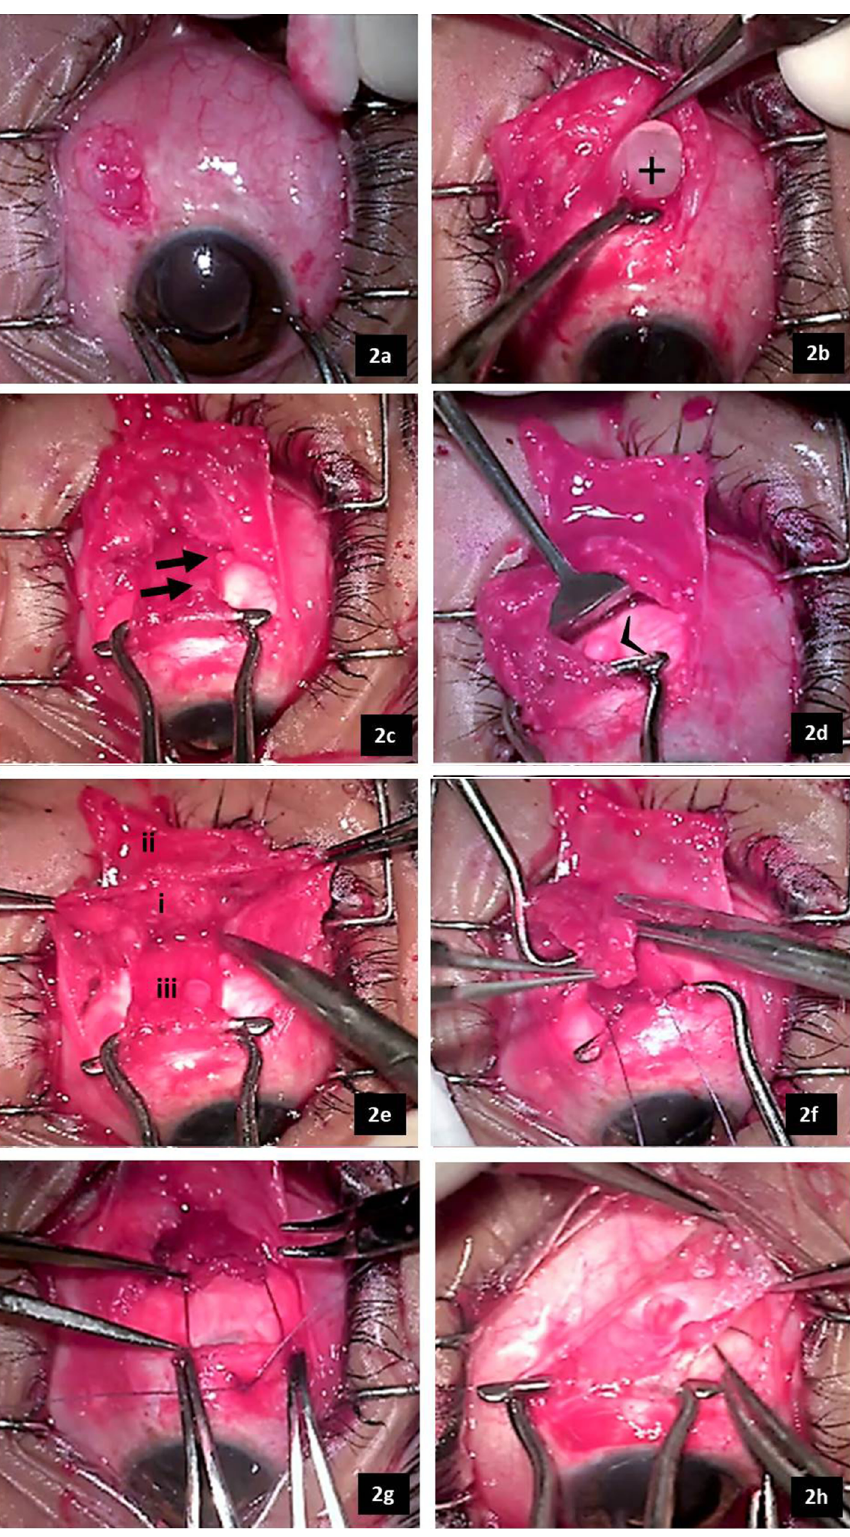
Figure 2: Intraoperative photographs showing the various steps of the strabismus surgery. 2a–g: Intraoperative photographs of the surgical field of lateral rectus recession. 2a: Multiloculated cyst encountered just beneath the conjunctival incision. 2b: Large uniloculated cyst (+) located within the anterior tenon’s capsule at the superior edge of the lateral rectus muscle. 2c: Small SiO cysts (arrows) embedded within the muscle sheath. 2d: SiO cysts located beneath the muscle (arrow head) in the episleral tissue. 2e: Shows the surgical field after separation of tenon’s capsule (i) from overlying conjunctiva (ii) and underlying LR muscle (iii). The thickened tenon’s fascia embedded with multiple small cysts can be appreciated. 2f: Shows resection of tenon’s fascia overlying the LR muscle. 2g: Shows sliding noose adjustable hangback recession of LR. 2h: Intraoperative photograph of the medial rectus resection showing a relatively clear surgical